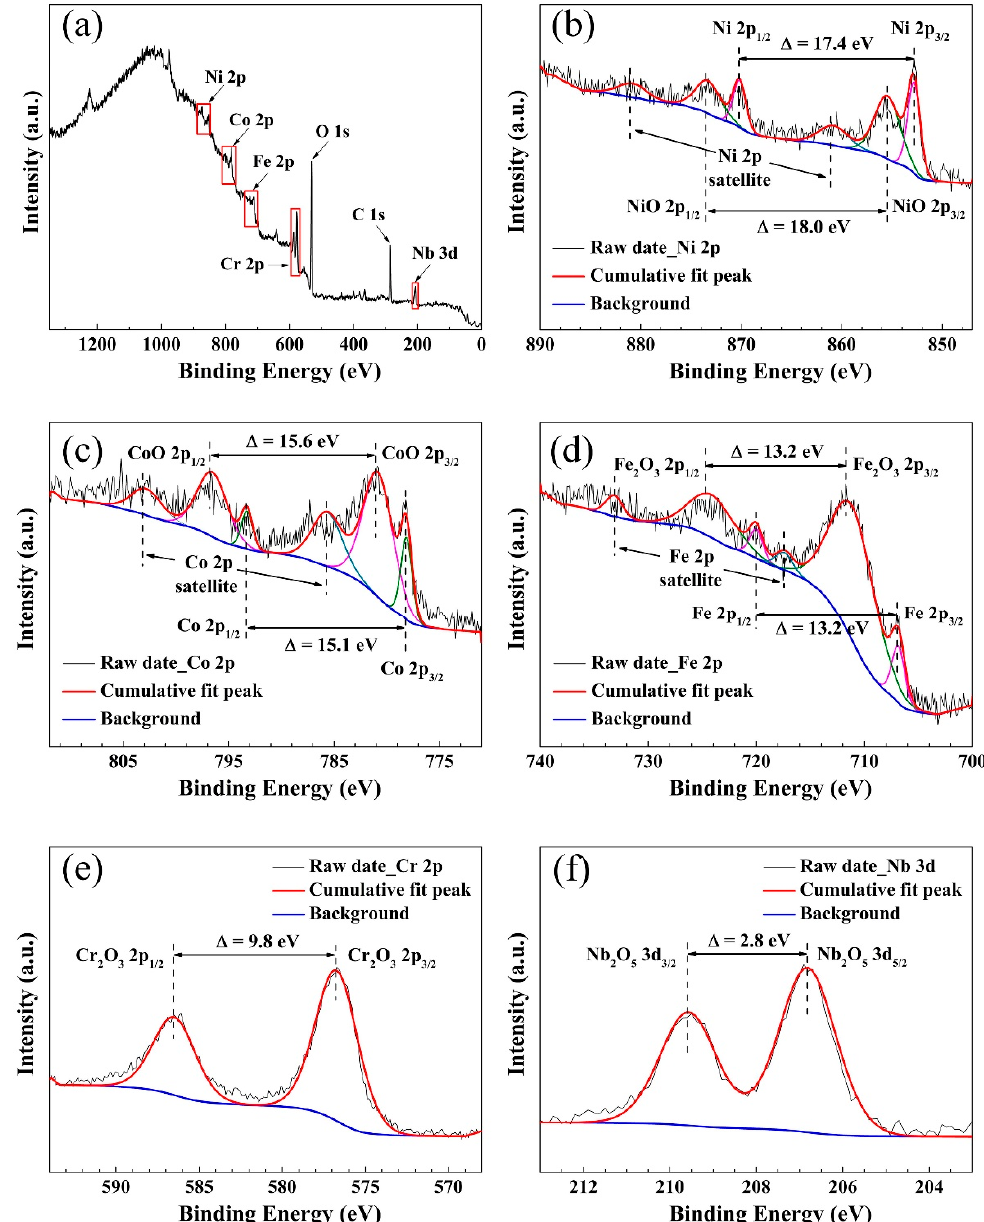
Figure 8. X-ray photoelectron spectrometer (XPS) spectra of the passivation film on (CoCrFeNi) 95 Nb 5 HEA coating ( a ) full survey, ( b ) Ni 2p, ( c ) Co 2p, ( d ) Fe 2p, ( e ) Cr 2p, ( f ) Nb 3d.